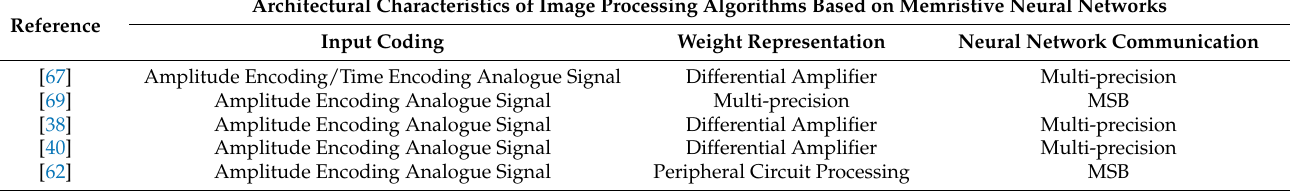
Table 4. Comparative information of memristive neural network-based image processing.